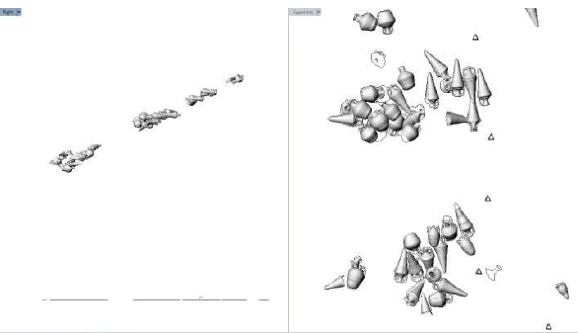
Figure 12. 2009-11 documentation: trilateration.